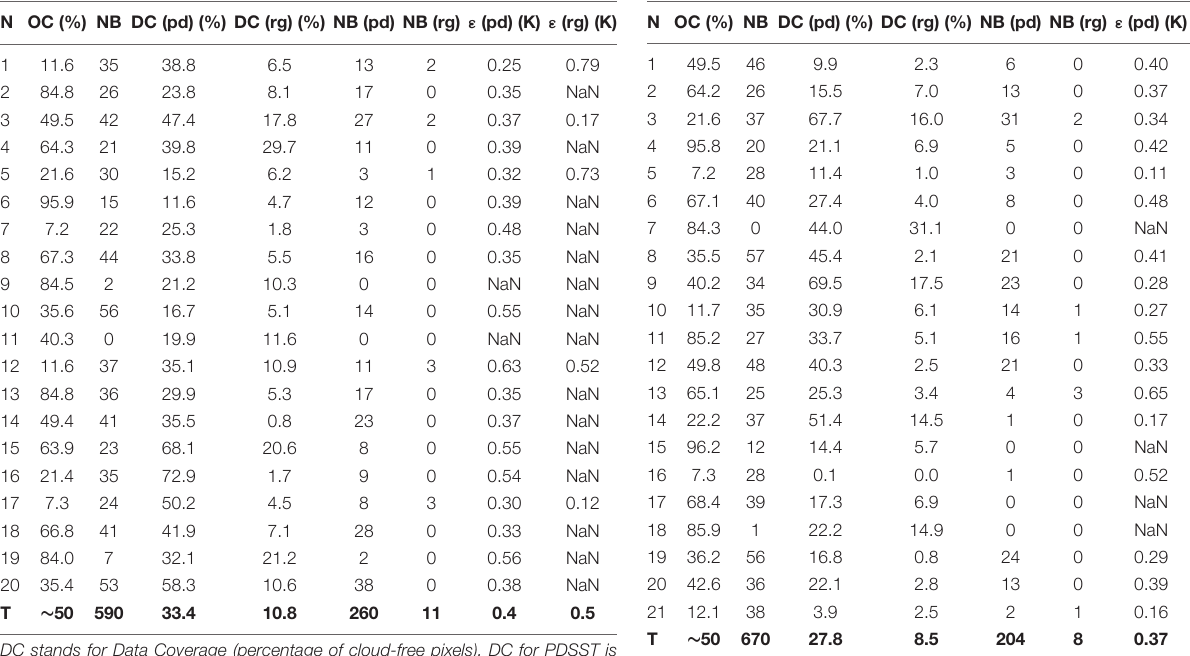
TABLE 2 | Statistical information of retrieved results for 21 granules from CC using two different methods of PDSST and RGSST5 for the month of December